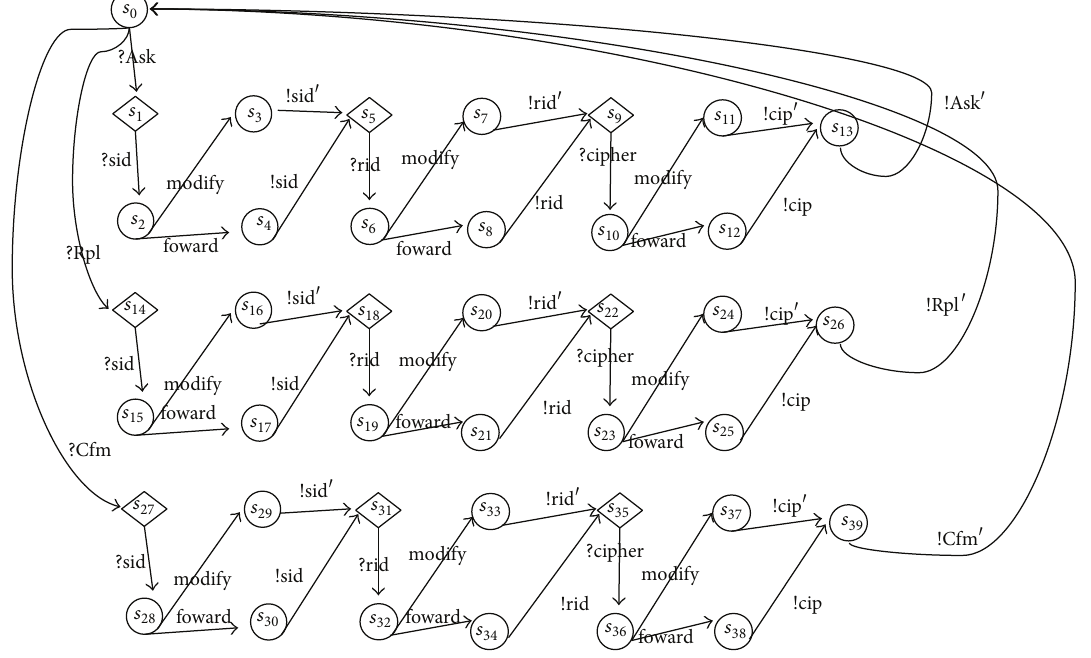
Figure 3: Intruder model of